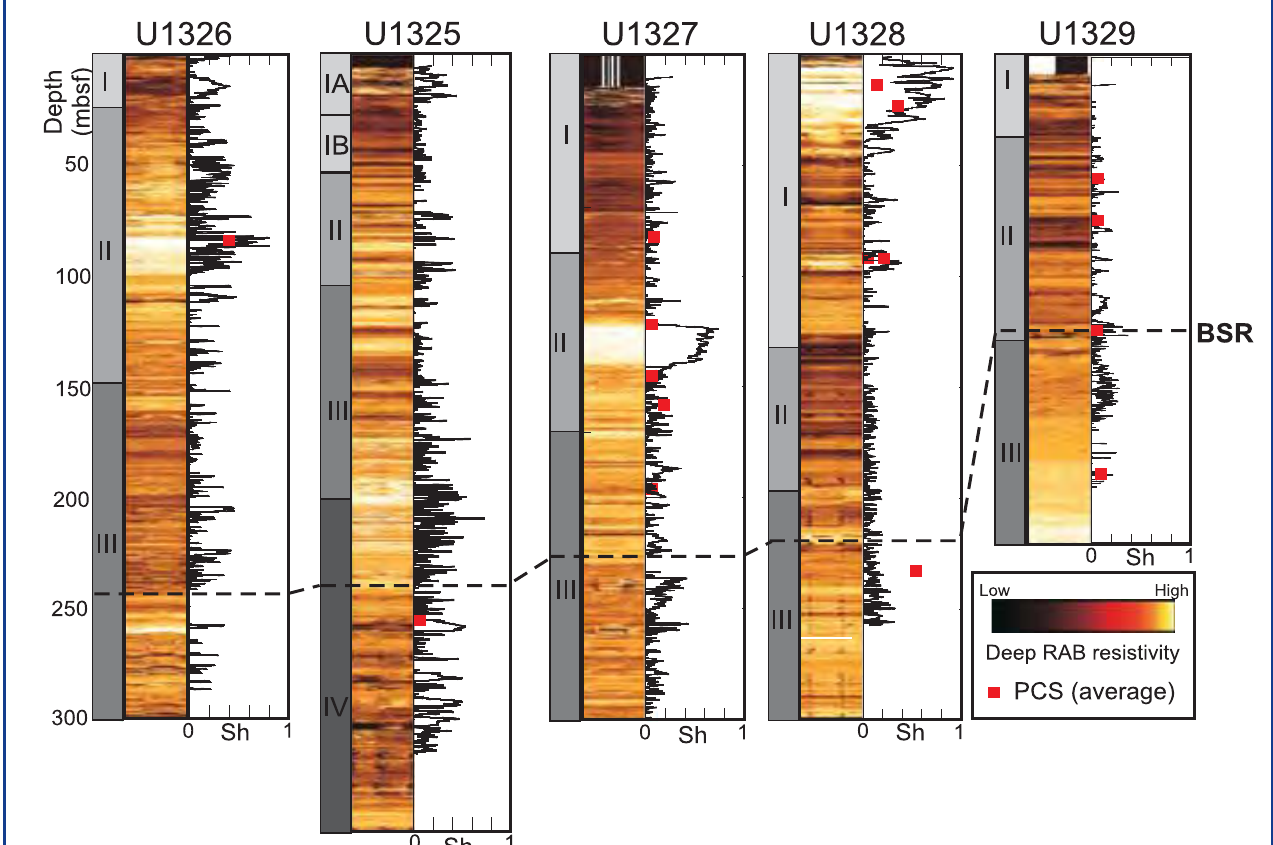
Figure 4. Summary of Expedition 311 gas hydrate concentration (Sh) derived from LWD data using Archie’s Relation. Also shown are lithostratigraphic units and LWD RAB resistivity images and location of